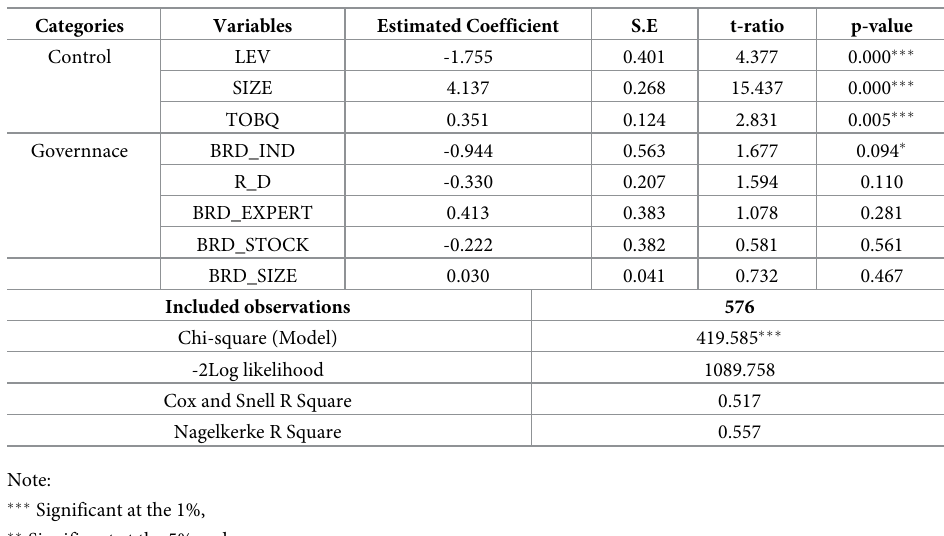
Table 11. Ordered logit regression (OLR)